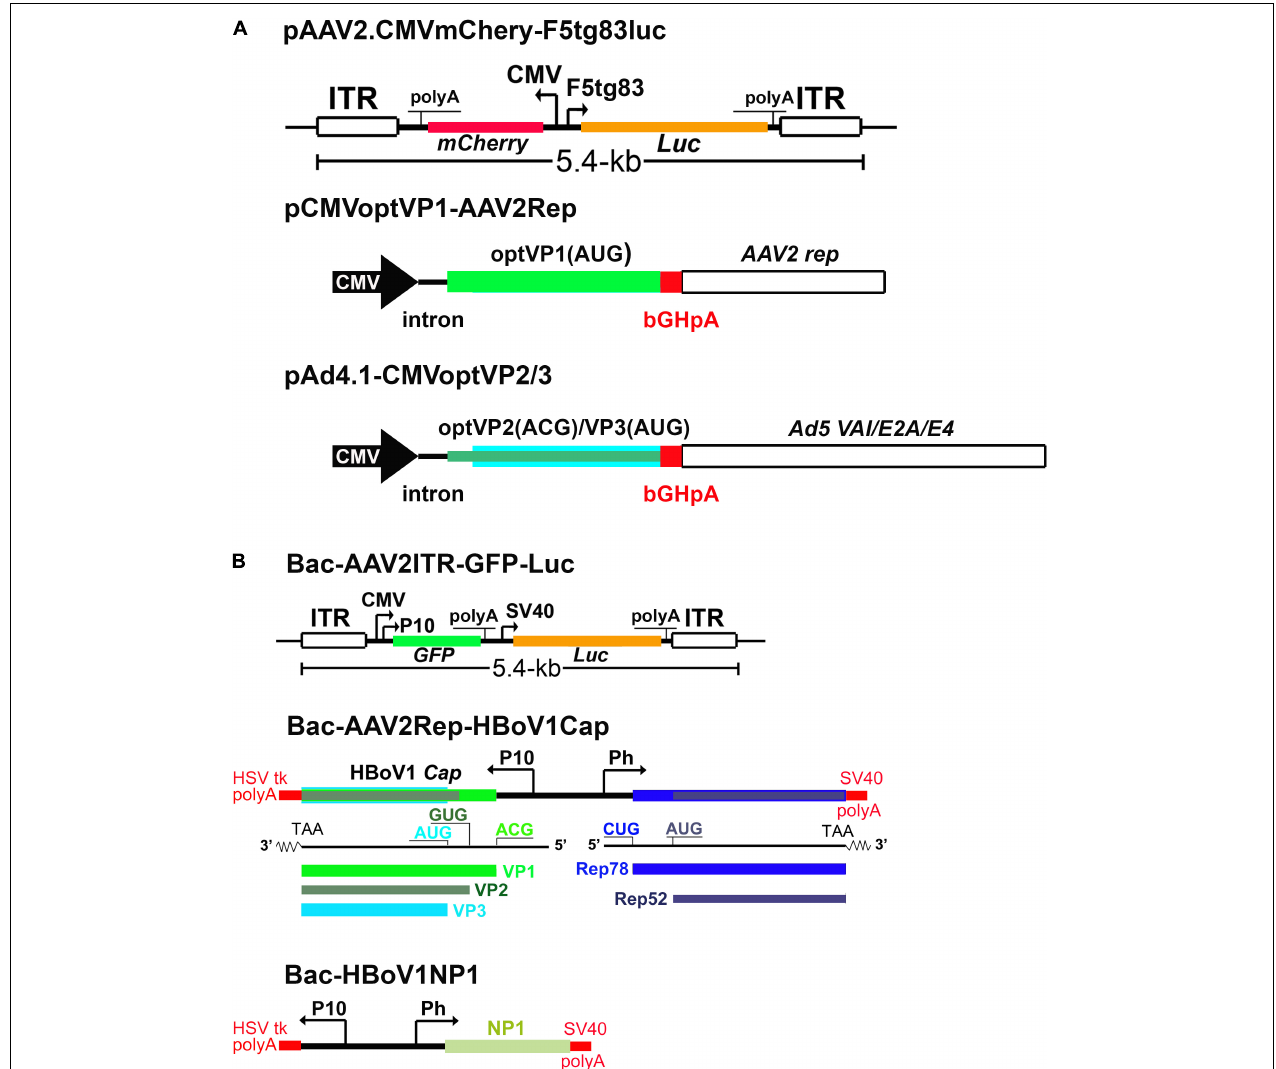
FIGURE 7 | rAAV2/HBoV1 vector production systems. (A) NS-free rAAV2/HBoV1 vector production system in HEK293 cells. pAAV2 carries the genes of interest in rAAV2 genome. pCMVoptVP1-AAV2Rep is a two-in-one plasmid, in which the VP1 and Rep2 (Rep78/52) are expressed in two independent cassettes. pAd4.1-CMVoptVP2/3 has the optimized (opt)VP2/3 expression cassette in the Ad helper gene expression plasmid pAd4.1. (B) rAAV2/HBoV1 baculovirus expression vector (BEV) production system. Bac-AAV2ITR-GFP-Luc carries an rAAV2 genome. Bac-AAV2Rep-HBoV1Cap expresses AAV2 Rep proteins and HBoV1 capsid proteins. Bac-HBoV1NP1 expresses HBoV1 NP1. P10 and Ph are baculoviral promoters, and CMV and F5 tg83 are a human cytomegalovirus major immediate-early promoter and a synthetic promoter, respectively. Various polyadenylation signals are indicated as polyA. Luc : firefly luciferase gene; GFP , enhanced green fluorescent protein gene, and mCherry , a monomeric red fluorescent protein gene. They can be replaced by any gene of interest (GOI) for expression in the vector.